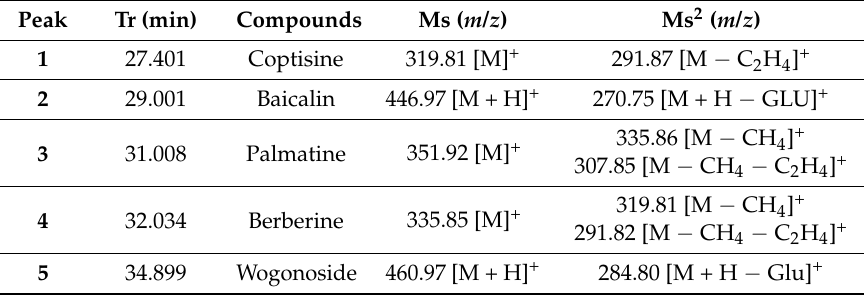
Table 2. ESI-MS n ions of the identified compounds.